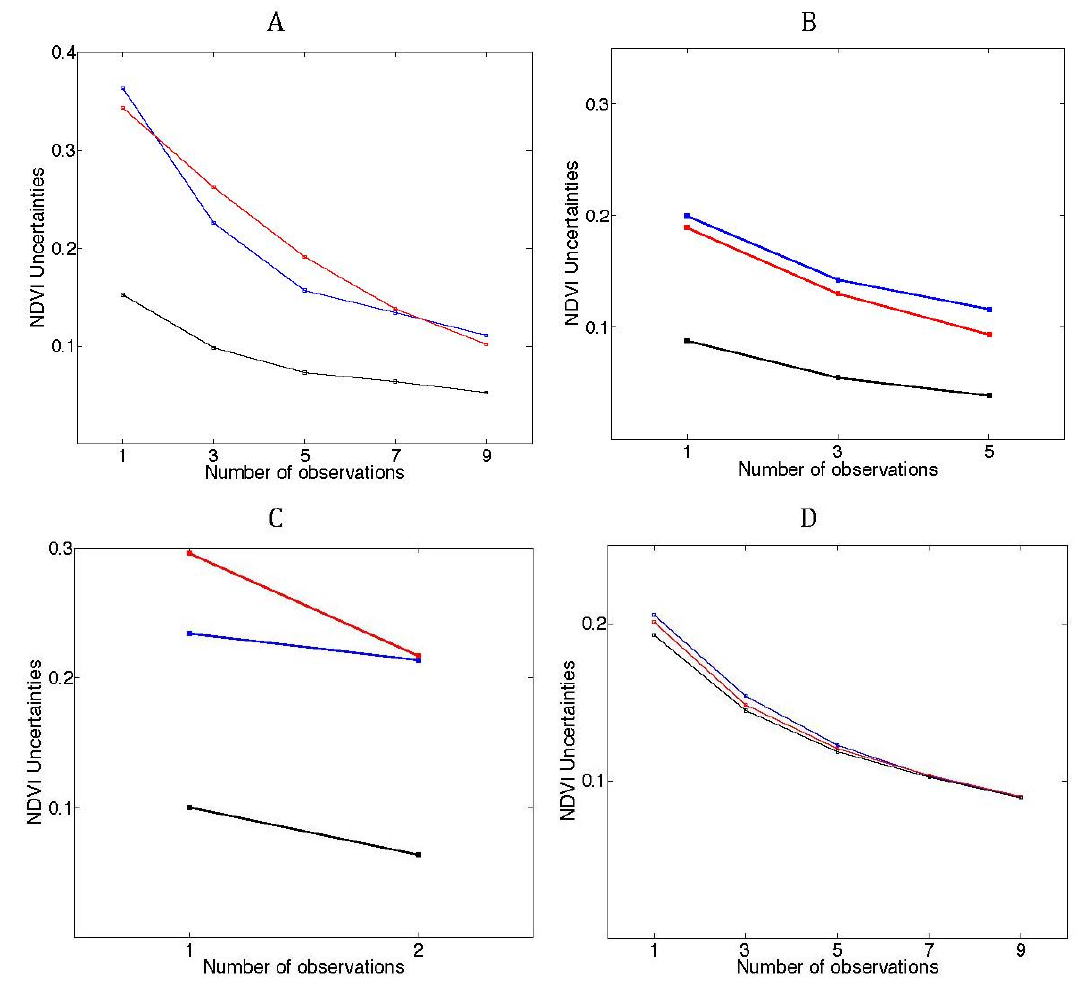
Figure 8. Sensitivity of temporal level mean uncertainties to the number of observations (Landsat scenes) used to generate the temporal sequence: ( A ) Kansas; ( B ) Mozambique; ( C ) Manitoba; ( D ) Arizona. Temporal sequence level mean uncertainties were calculated from all temporal sequences generated with the same number of Landsat observations in Monte Carlo simulations. NDVI uncertainties are4 expressed as the standard deviation of the NDVI value for that state. Forward mode recursion (blue line); backward mode recursion (red line); combined mode recursion (black